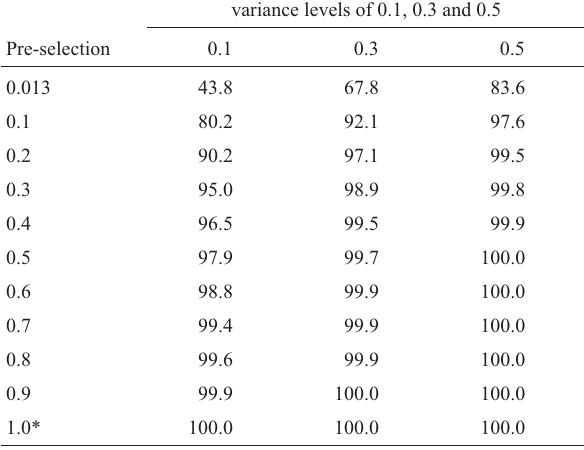
Table 5 - Scheme A2: Percentage total response for age at first calving (AFC) two-stage marker assisted selection at the embryo stage (embryo selectionrate0.0125to1)andattwo-yearsoldatadditivegeneticvariance levels of 0.1, 0.3 and